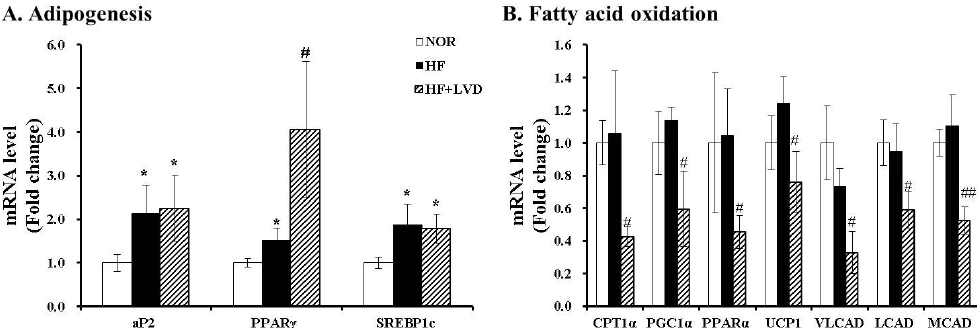
Figure 2. Influence of vitamin D insufficiency on gene expression involved in adipogenesis ( A ) and fatty acid oxidation ( B ). mRNA levels were determined by RT ‐ PCR and normalized for all samples to β‐ actin. The results are expressed as the fold change compared to NOR. The value of each bar represents the mean ± SEM. * p < 0.05; ** p < 0.01 compared to NOR. # p < 0.05; ## p < 0.01 compared to HF. NOR, 10% fat diet with 1000 IU vitamin D ( n = 9); HF, 45% fat diet with 1000 IU vitamin D ( n = 7); HF+LVD, 45% fat diet containing 25 IU vitamin D ( n = 7).